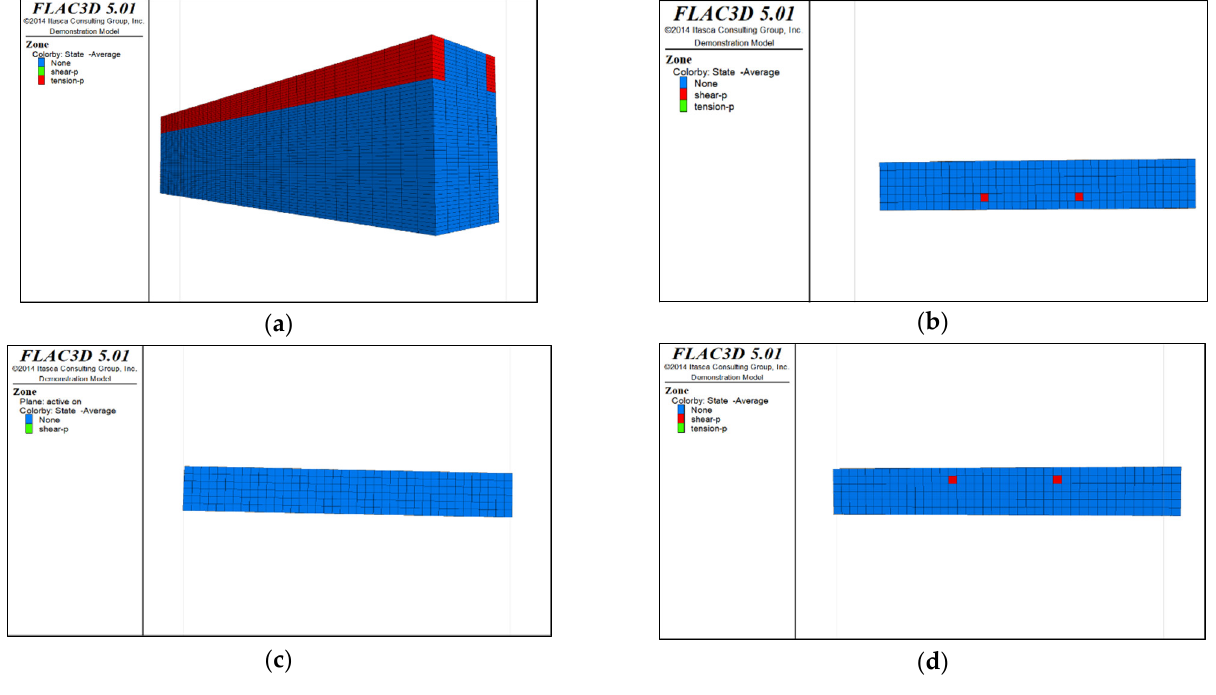
Figure 7. Distribution of plastic zones in the roof protection layer under Scheme D. Note that the heigt of each slice is 0.5m. ( a ) 3D drawing. ( b ) plan of roof protection layer (the first slice). ( c ) plan of roof protection layer (the second slice).